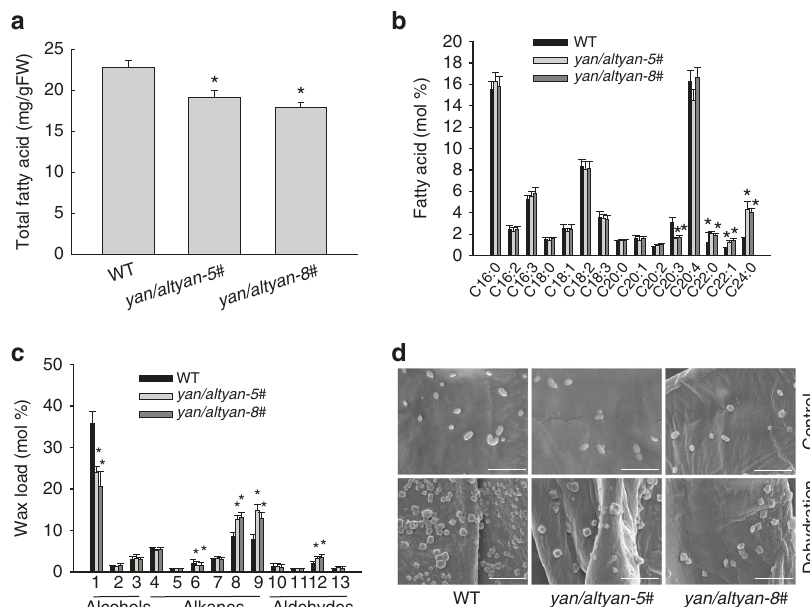
Fig. 3 Quanti fi cation of fatty acids and wax loads in wild-type plants and yan/altyan mutants. Ten-week old plants were used to detect the composition and total amount of fatty acids and waxes. Results represent means and standard deviations of three biological replicates for the wild-type and two independent mutants. Asterisks indicate a statistically signi fi cant difference compared with wild-type plants based on a two-tailed Student ’ s t test ( p < 0.05). a Total fatty acid content in the wild-type and yan/altyan . b Fatty acids composition in wild-type plants and yan/altyan mutants. c Wax composition in wild-type plants and yan/altyan mutants. 1. 16-Hydroxy ent-kaurane; 2. 1-Tetracosanol; 3. 1-Hexacosanol; 4. Octadecane-1-bromo; 5. Kaur-15-ene; 6. Ent-kaurene; 7. 1,19-Eicosadiene; 8. 1,21-Docosadiene; 9. 1,21-Tetracosene; 10. Octadecanal; 11. Eicosenel; 12. Docosanal; 13. Tetracosanal. d Wax crystals observed using scanning electron microscopy. Scale bar = 2 μ